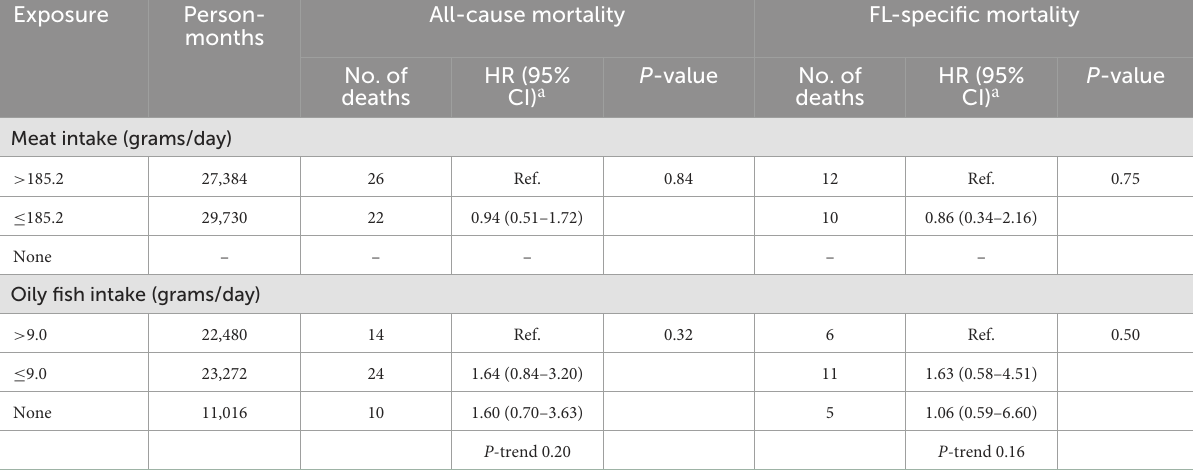
a Multivariablemodel—adjustedforage,sex,ethnicity,stateandsmokingstatus.